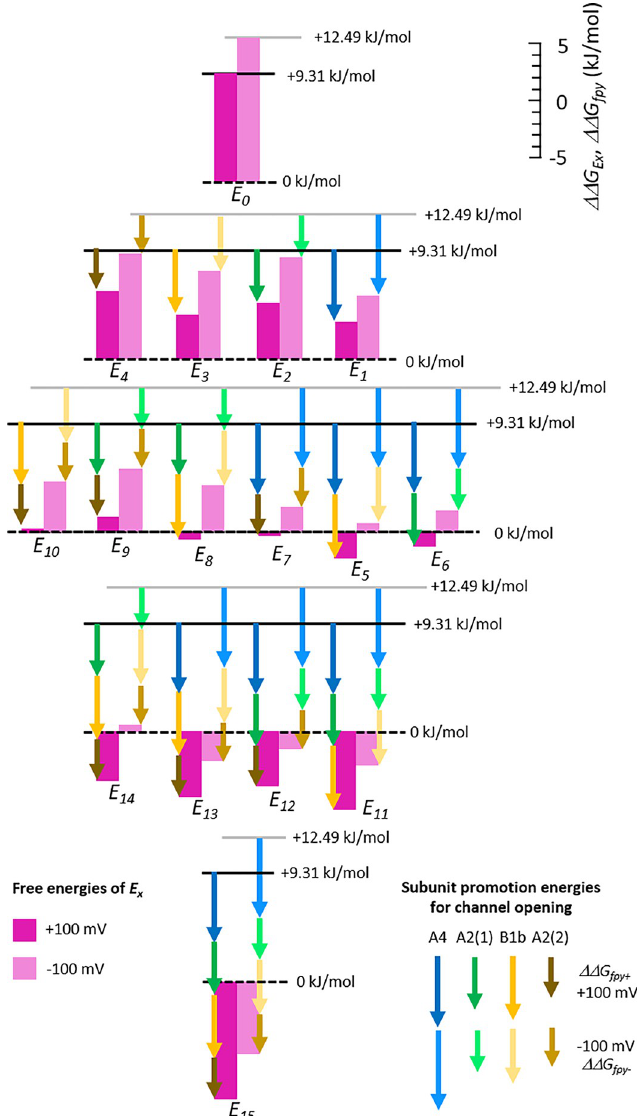
Fig 4. Components of free energies for 16 closed-open isomerizations. In the fit with the 29 HACO model, subunit- specific promotion factors for opening, fp , were used by which the closed-open isomerization constant of the empty n channel, E 0 , is shifted to the open state. The fp n values are either unity for the empty subunit or adopt a specific value if leads to 16 combinational products of the five parameters at both the subunit is liganded. Disassembling of the 16 E x +100 mV ( E 0+ , fp 1+ ... fp 4+ ) and -100 mV ( E 0- , fp 1- ... fp 4- ). From these values specific subunit promotion energies for and DD G (colored arrows) by using Eq (16) which channel opening were obtained as Gibbs free energies, DD G fp y þ fp y (cid:0) were subtracted from the DD G and DD G values (magenta bars), respectively, illustrating their additive genesis. E 0 þ E 0 (cid:0) Overall, successive liganding forces the open-closed isomerizations increasingly to an open state, some more at +100 mV than at -100 mV. Hence, the different ΔΔ G Ex values at equal degree of liganding can be reduced to the energetic contributions of the different subunits.